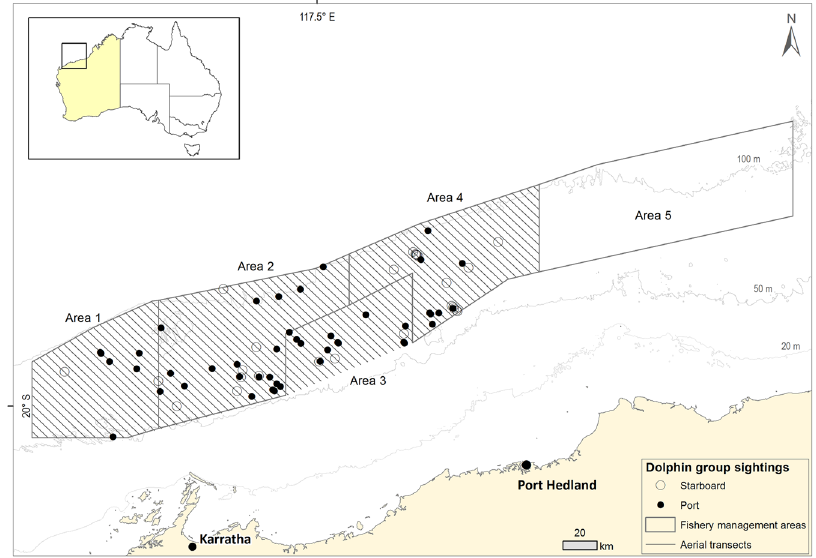
Figure 1. Aerial tracks surveyed in April 2011 across the Pilbara Trawl Fishery, north-western Australia; Fishery management areas 1, 2, 3 and 4 were surveyed (trawling is not permitted in area 3; area 5 was not surveyed); Circles indicate dolphin sightings ( ● = port observer/s, ○ = starboard observer); 20 m, 50 m and 100 m depth contours are also indicated. This figure was generated in ArcGIS